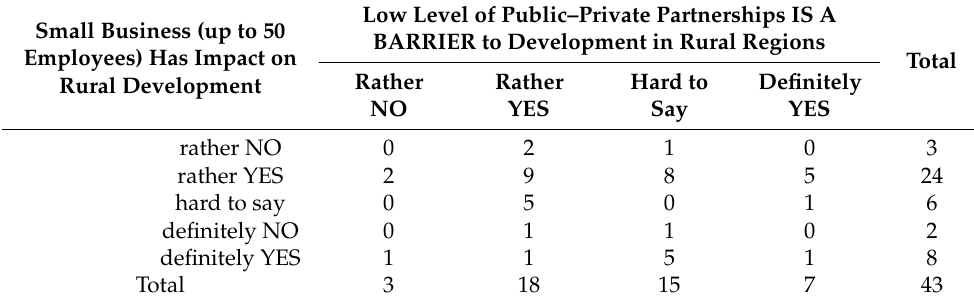
Table 3. Opinion of supporters of the view that small business has a large impact on rural develop- ment on the importance of public–private partnerships in this